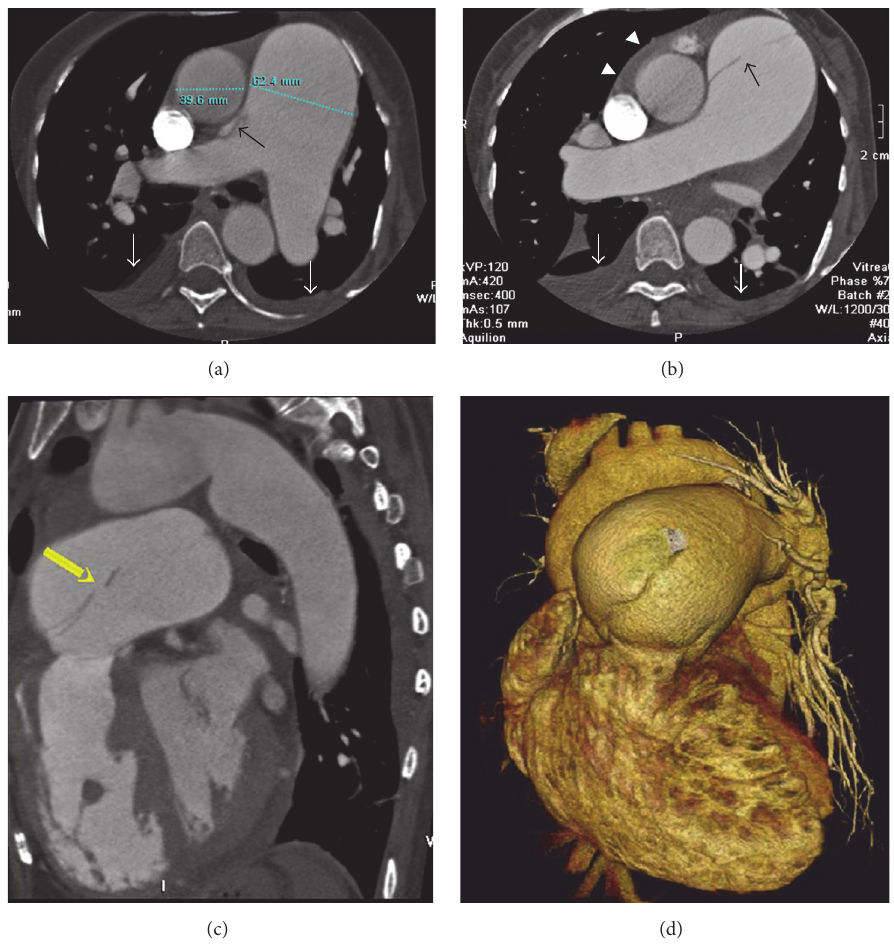
Figure 3: Intimal flap features determined on CT angiography. Transverse sections of CT pulmonary angiography (a, b) showing dilated central pulmonary arteries with an intimal flap (black arrow) in the main pulmonary trunk and right pulmonary artery. Pericardial effusion (white arrowheads) and bilateral pleural effusion (white arrows) are also noted. Sagittal MPR reconstruction (c) revealed the primary entry tear (arrow) in the proximal main pulmonary trunk and retrograde extension of the intimal flap to the pulmonary valve. Volume rendered images (d) vividly demonstrated the relationship between the intimal flap and pulmonary artery